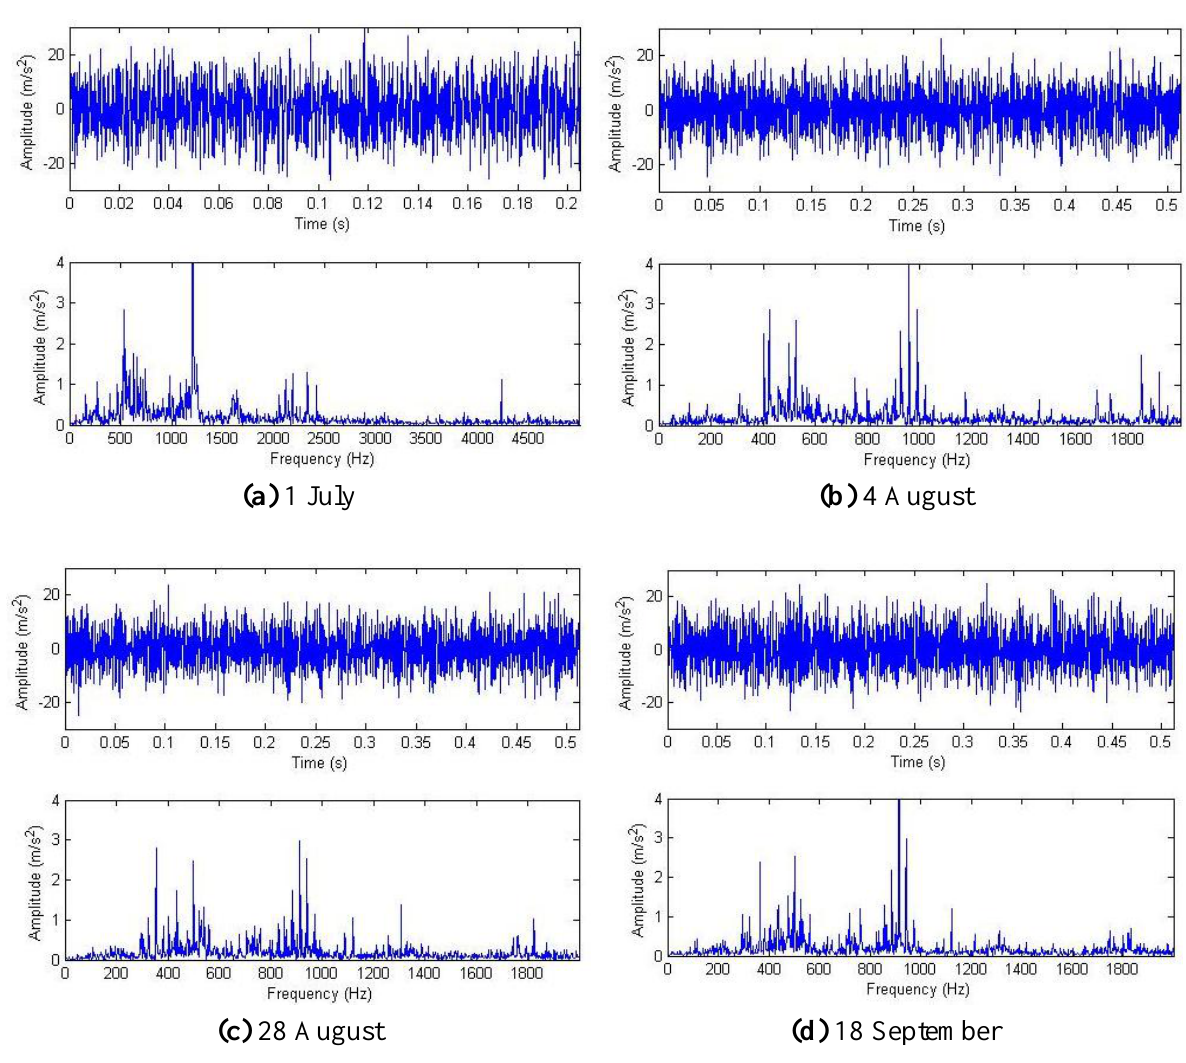
Figure 18. Waveforms and frequency spectra of historical